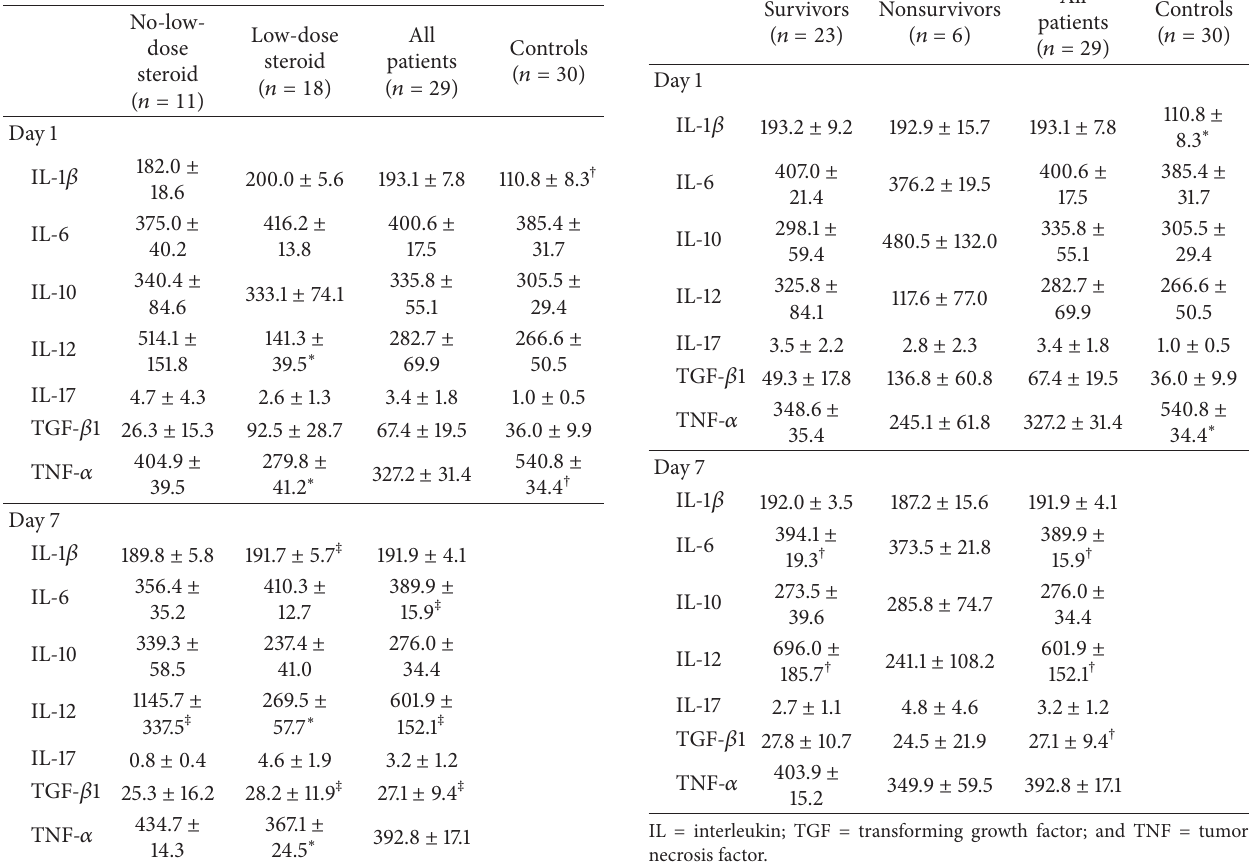
Table 3: Cytokine responses (pg/mL, mean ± standard error mean) on days 1 and 7 in no-low-dose steroid, low-dose steroid, and control groups.